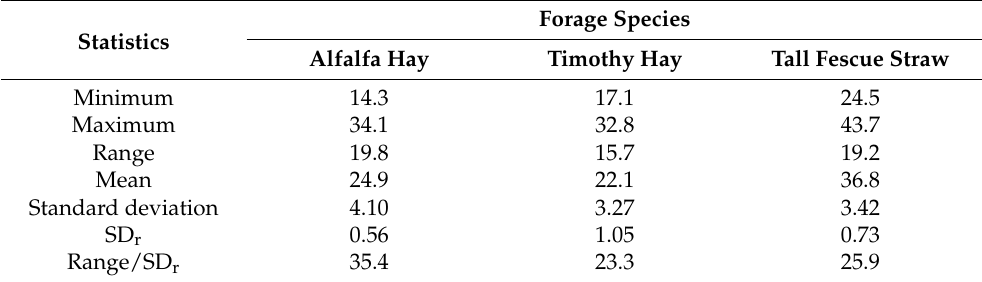
Table 4. Descriptive statistics of undigested NDFom concentration (% of DM) from three forage species used in building the calibration dataset (experiment 2) 1